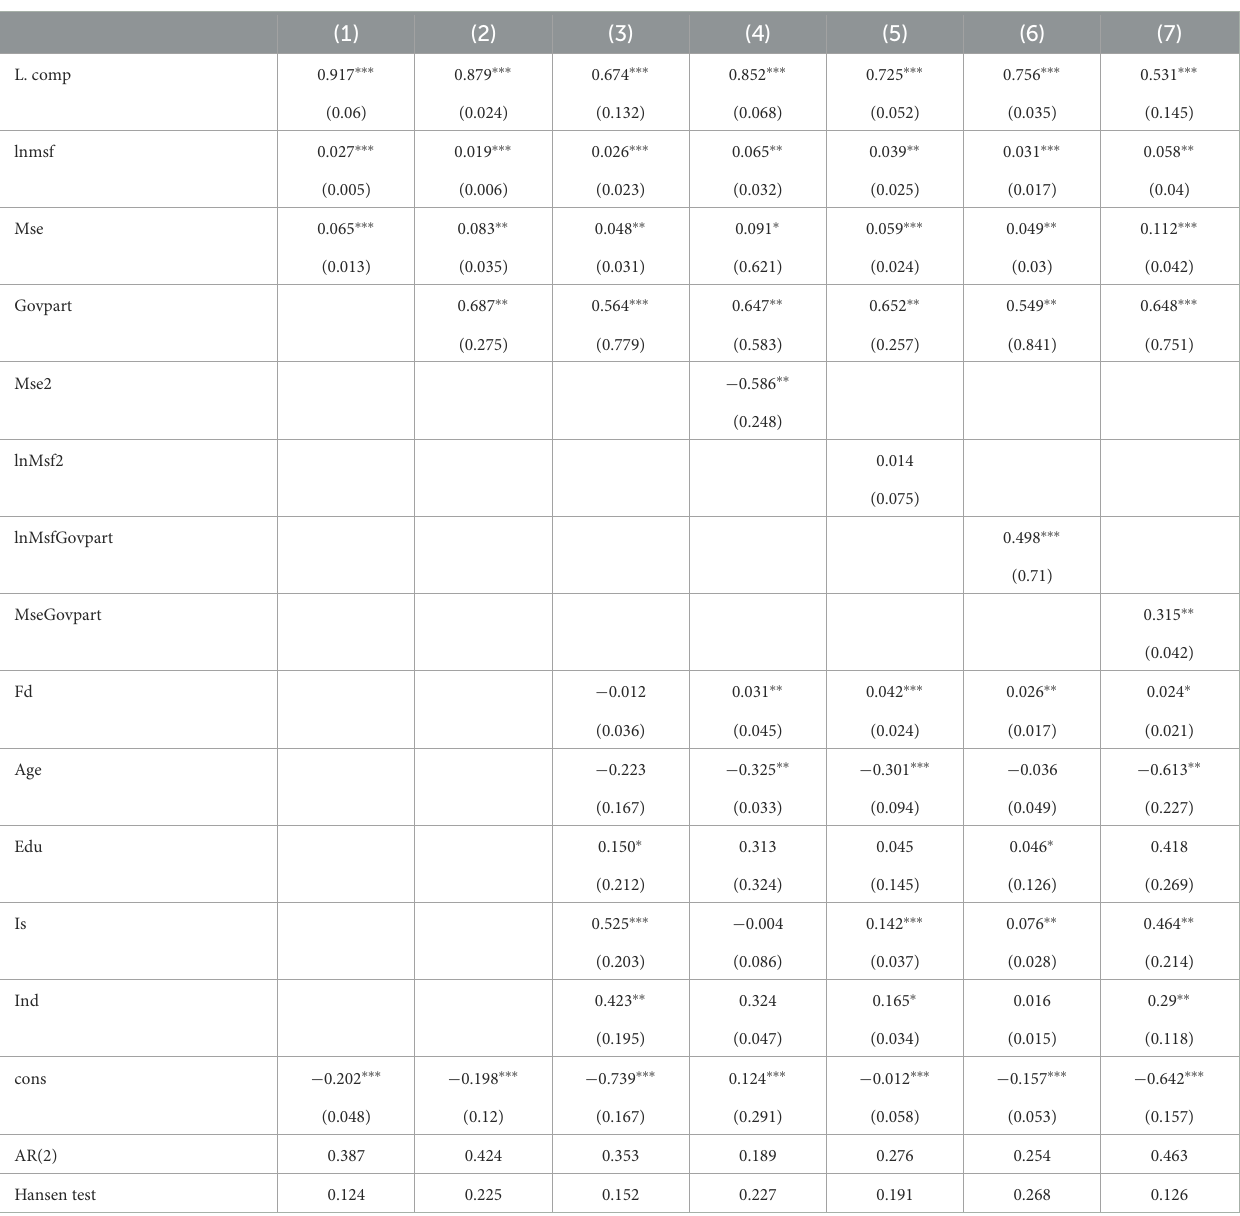
TABLE 3 Systematic GMM regression results for Equations